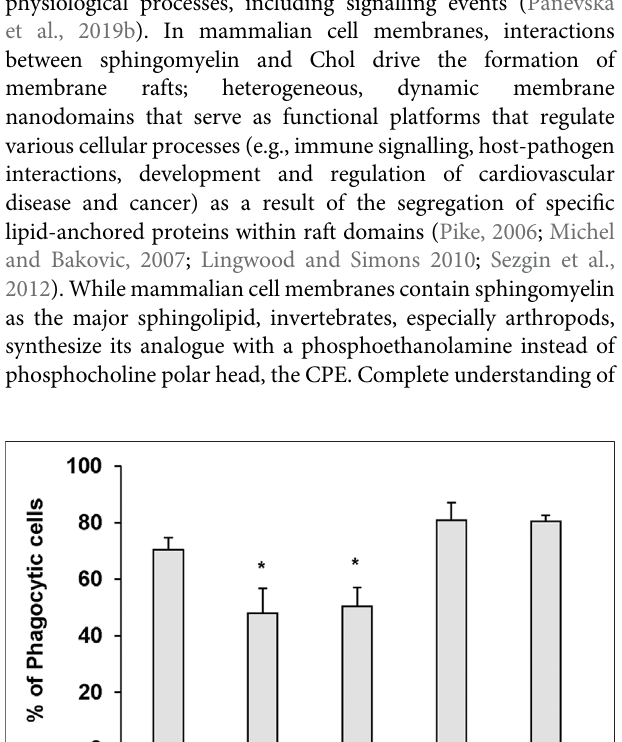
concentrations of the mixture induced a signi fi cant increase in the ratio Annexin V-FITC (ANX)/propidium iodide (PI) (+115 and +170%, respectively, vs. controls). Moreover, a signi fi cant increase in TMRE fl uorescence was detected at 50 μ g/ml (+44% with respect to controls). For oxidative stress parameters, MitoSOX and C-DCF fl uorescence signi fi cantly increased at both concentrations (+25 and +115% for MitoSOX; +117 and +97%, for C-DCF, respectively, vs. controls), while a decrease in glutathione signal was detected (-35 and -39%, respectively, vs. controls) ( Figure 9 ).